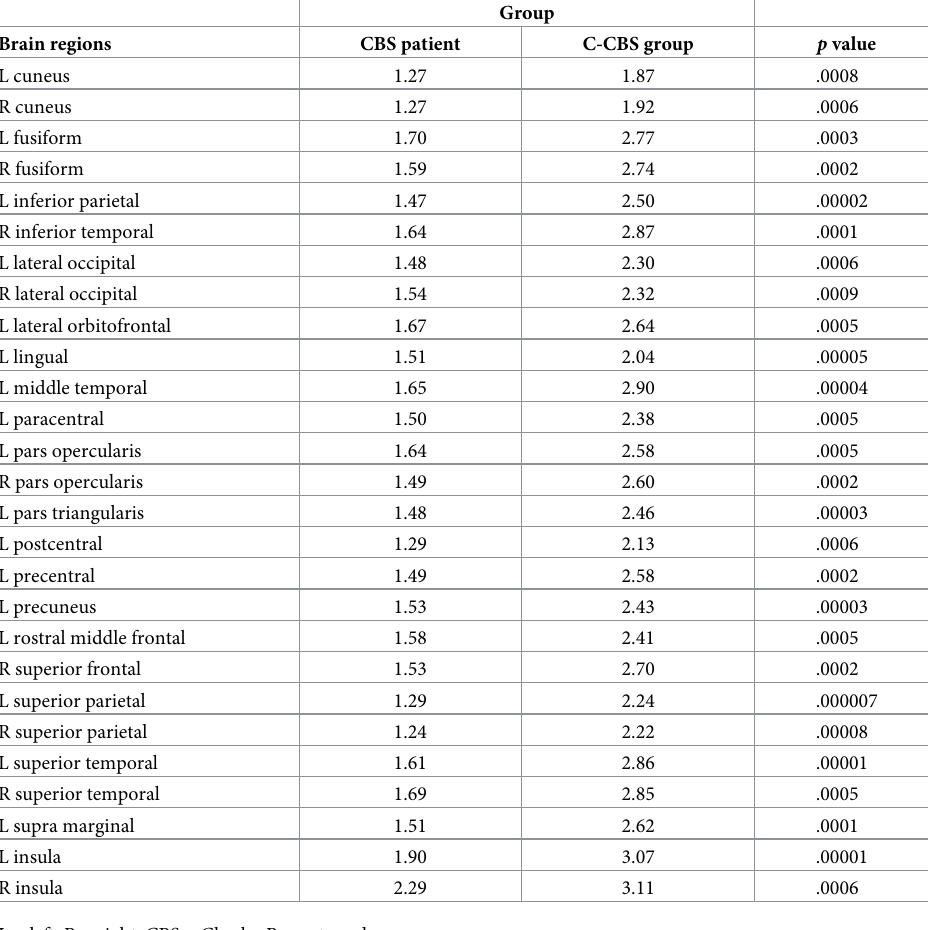
Table 2. Cortical thickness differences between CBS patient and